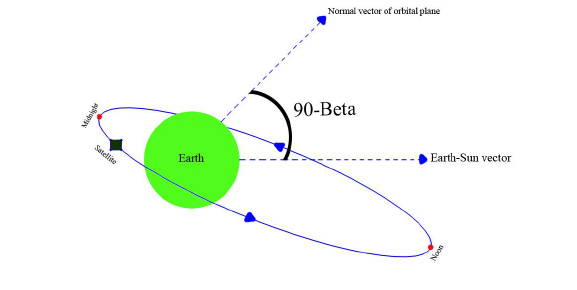
Figure 3: Midnight and Noon maneuvers (Beta is the elevation of the sun with respect to the orbital